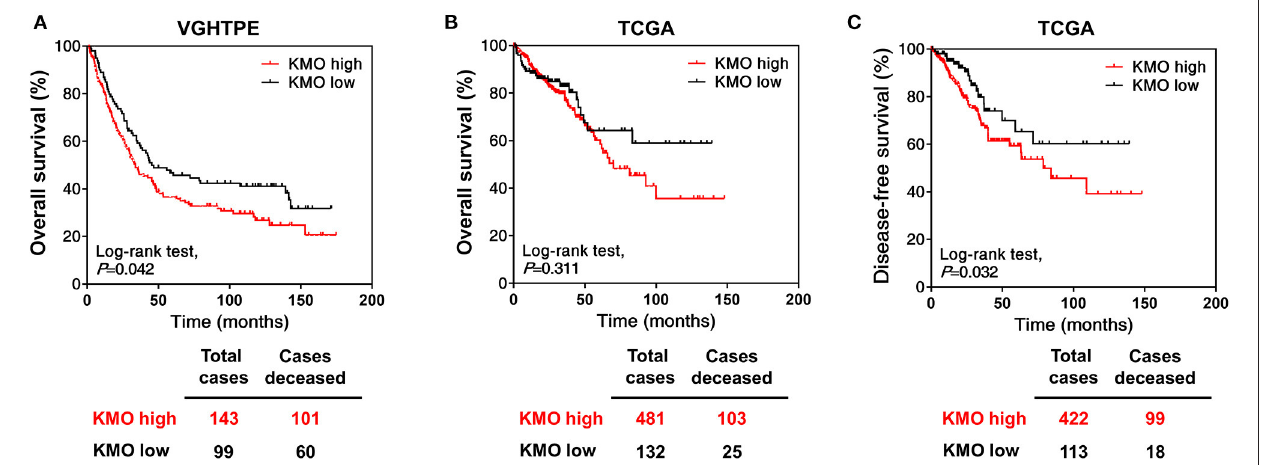
FIGURE 2 | High KMO expression is associated with poor overall survival. (A) Overall survival of CRC patients from VGHTPE was plotted against time in month for the protein levels of KMO. (B,C) The level 3 data of mRNA RSEM from patients with CRC were selected from the TCGA and Broad GDAC Firehose data portal. Overall (B) and disease-free survival (C) curves were plotted for CRC patients with high or low transcript expressions of